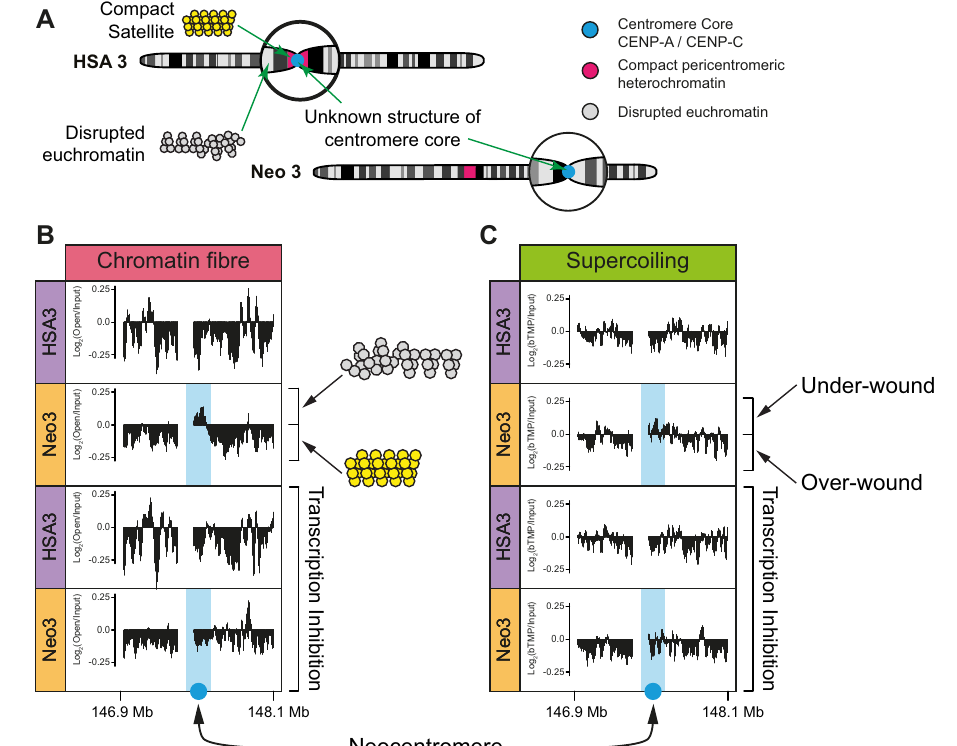
Fig. 4 | Centromeric chromatin has a transcription-dependent underwound anddisrupted chromatin fi brestructure.A Top,schematicindicating thelackof understanding of chromatin structure at canonical centromeric chromatin (HSA3) and after centromerisation (Neo3). B DNA corresponding to ‘ open ’ or disrupted chromatinwasisolatedbysucrosegradientfractionationofchromatinfollowedby PFGE and used to map the chromatin fi bre structure in the centromeric domain.